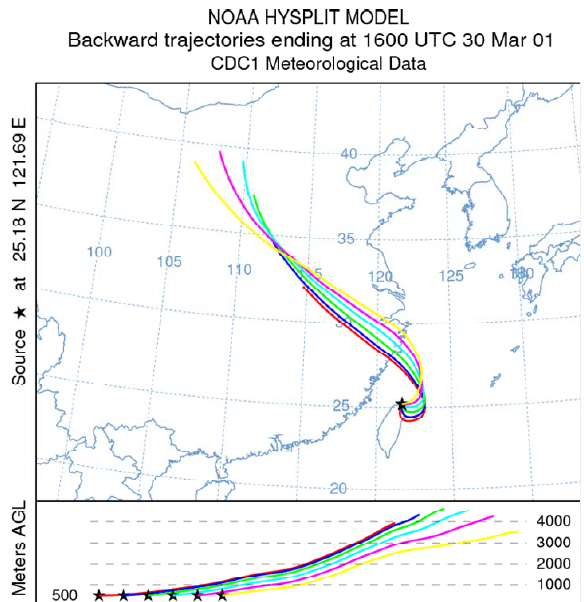
Fig. 3. Backward trajectory analysis generated from the NOAA HYSPLIT model. The starting time of each trajectory is 4h apart, from 00:00 (yellow curve) to 24:00 (red curve) local time on 30 March